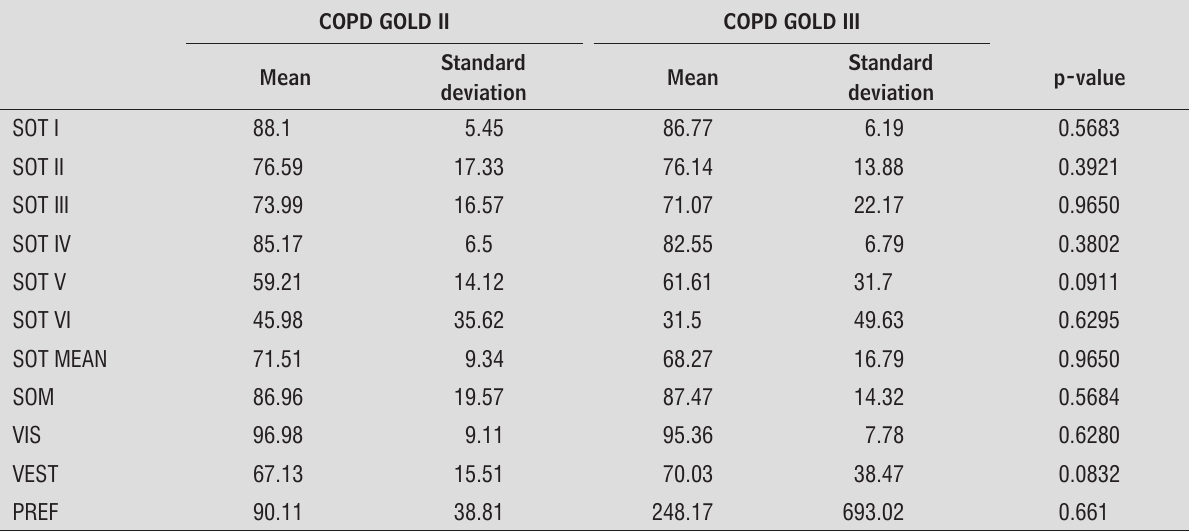
Standard Mean deviation